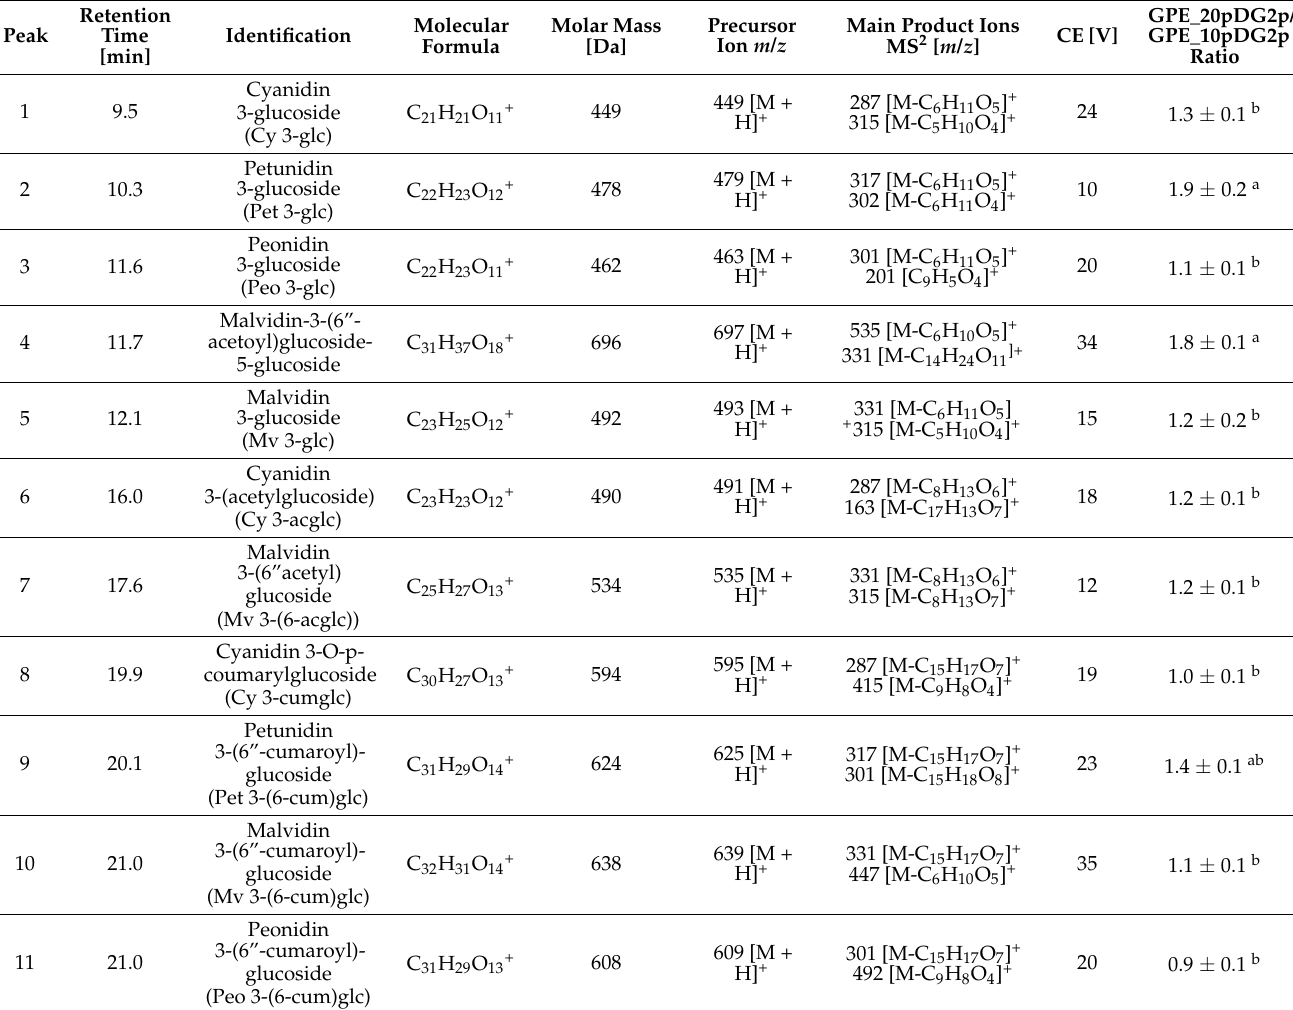
Table 2. Anthocyanin compounds identified using UPLC-ESI-MS/MS in positive-ion mode